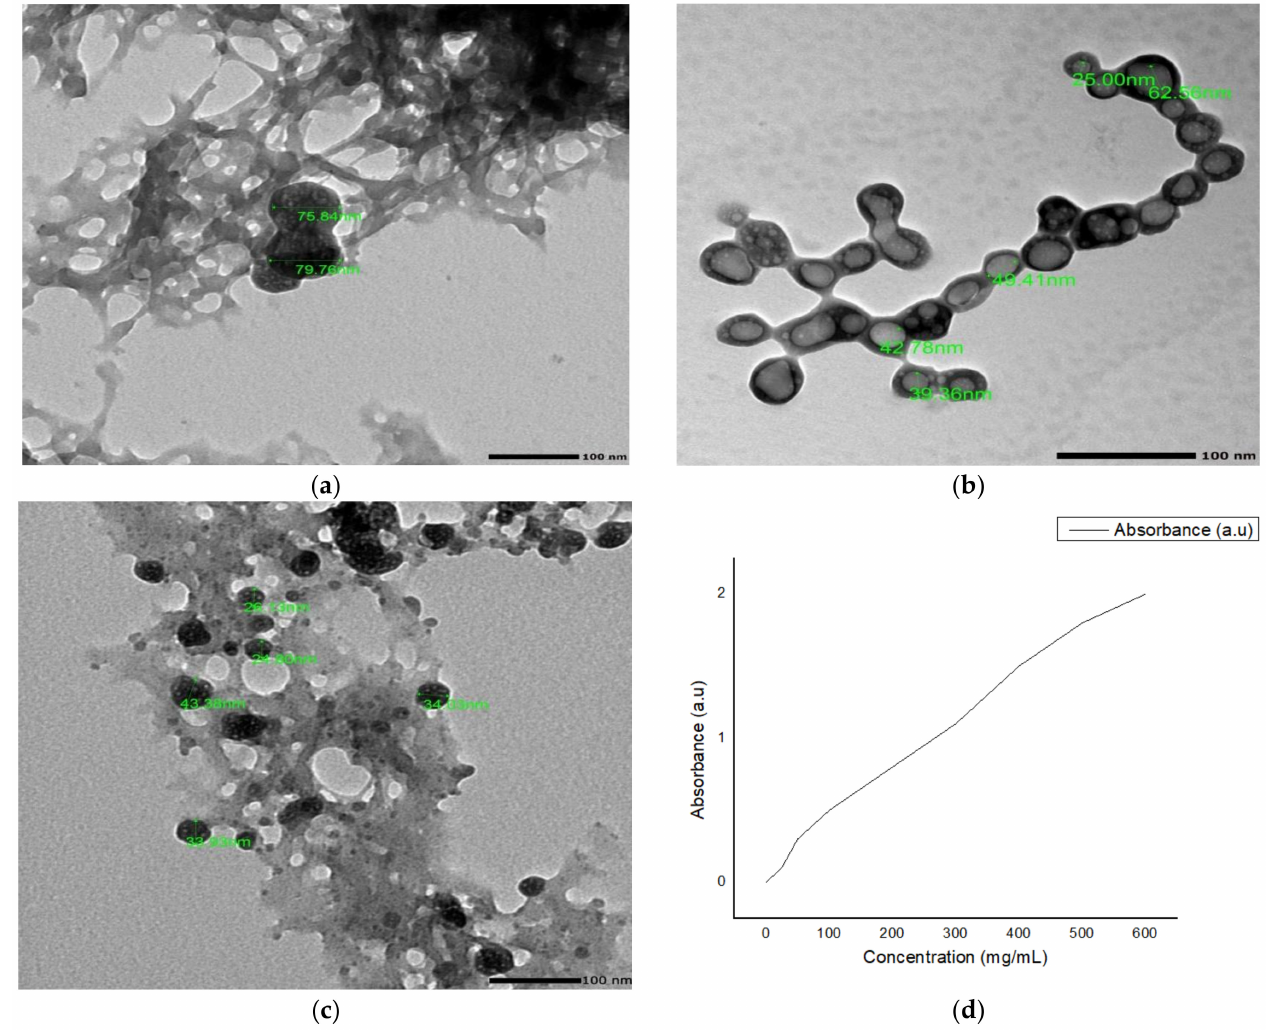
Figure 4. TEM micrographs of NCs-3a ( a ), NCs-3b ( b ), NCs-3c ( c ) nanoparticles (100,000 × ) and ( d ) calibration curve of the synthesized sulfonamide-1,2,3-triazole molecular